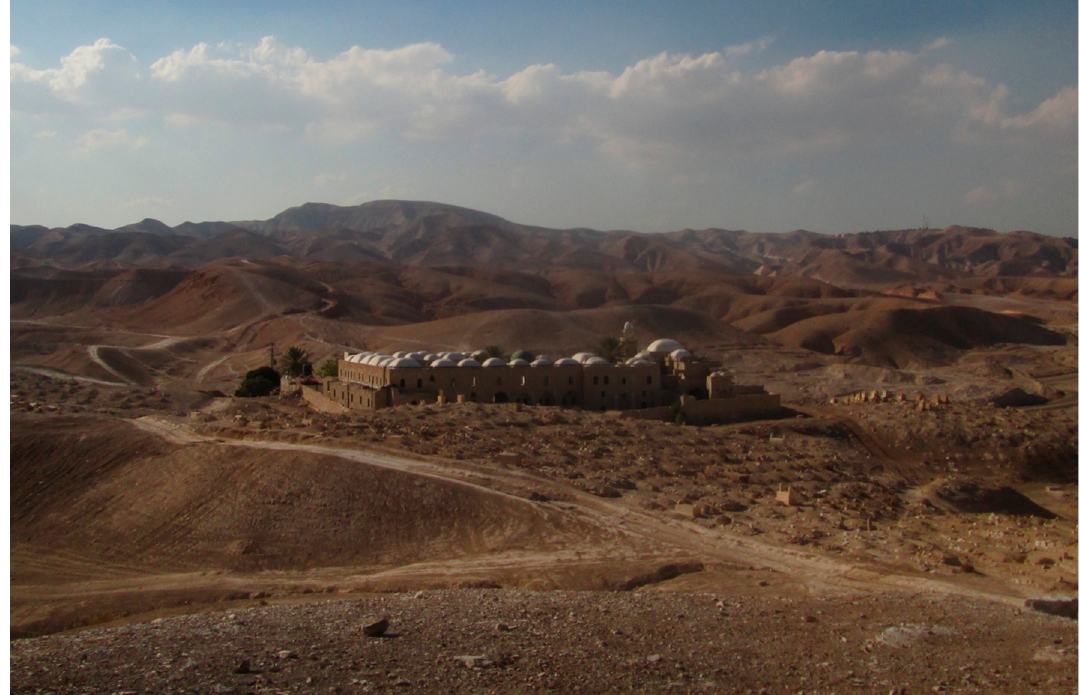
Figure 4. The shrine of Nab ī M ū s ā viewed from a subsidiary shrine uphill from the main complex. Photo by the author, October 2017.